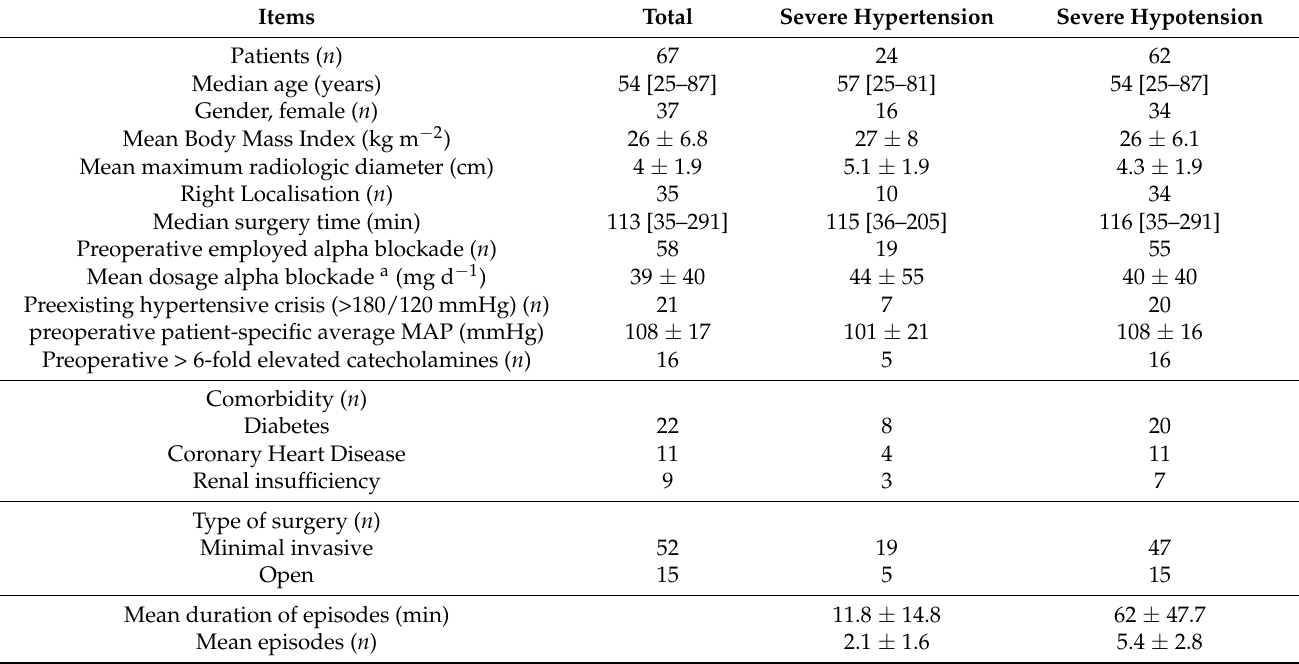
Table 1. Patient